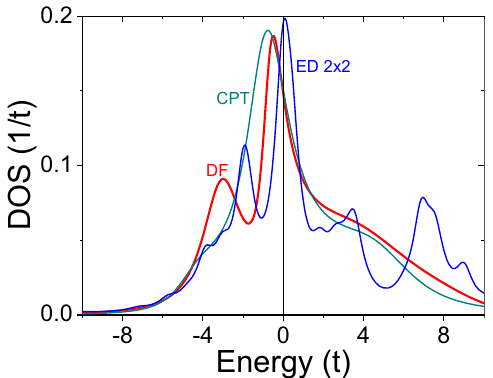
Fig. 5 Spectral function. Density of states for dual fermion plaquette second order scheme (DF) in comparison with the cluster perturbation theory (CPT) and exact diagonalization (ED) of 2 × 2 ¼ t 0 ¼ 0 : 15 μ = 0.48 and μ = 1.55, β = 3. plaquette for U = 5.56, t 0 0 0